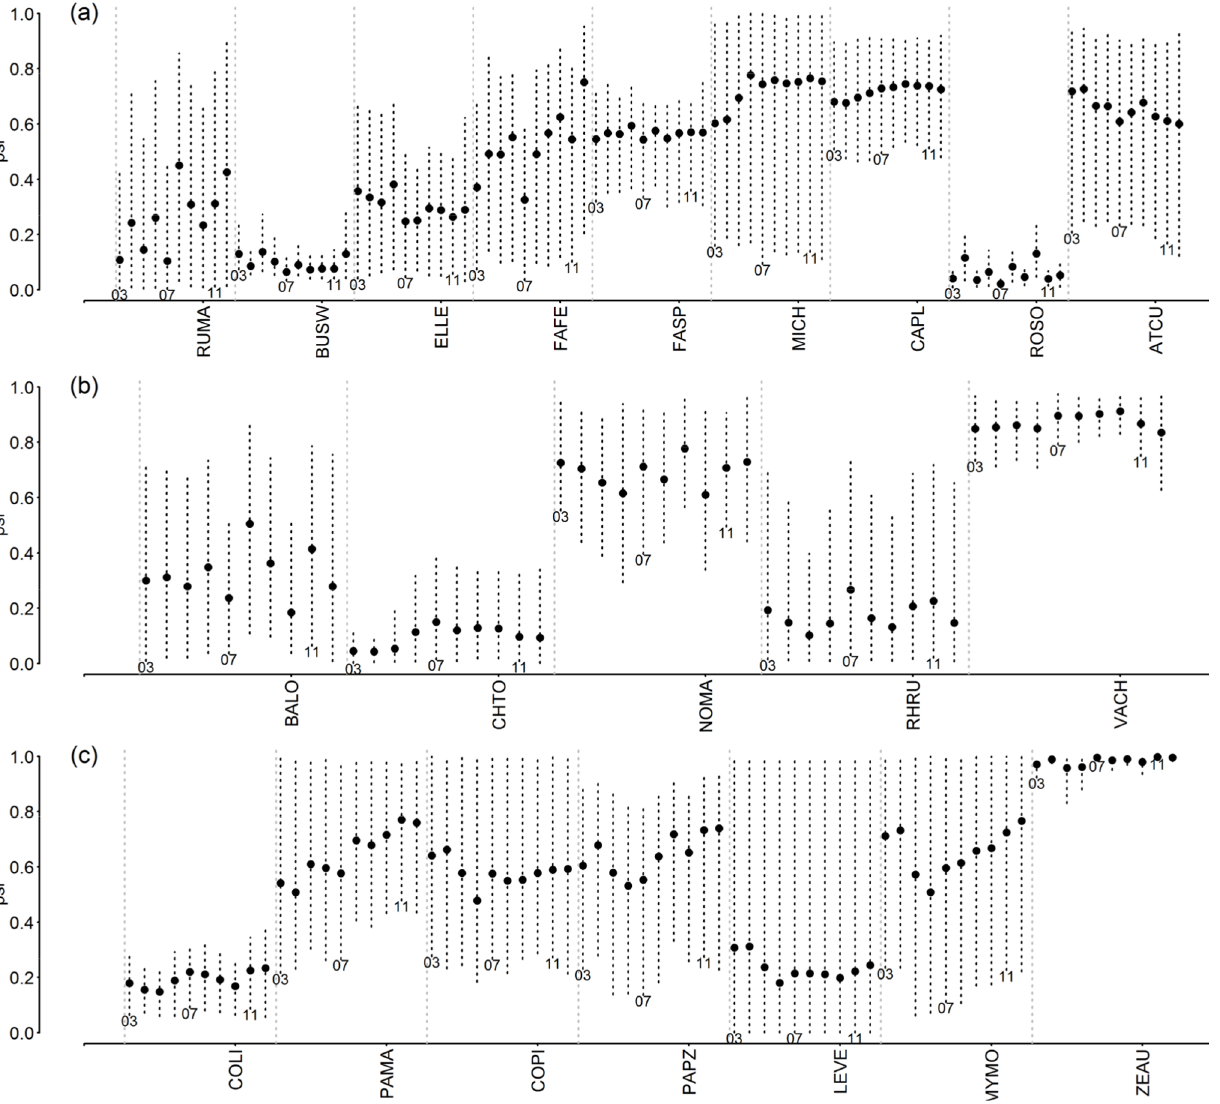
Fig 3. Mean occupancy ( ^ ψ ± SD, 95% BCI) for the complete study area during 2003 – 2012, in the regional bird monitoring program in Argentina for Non Passeriformes species. (a) Raptors; (b) ground omnivores and herbivores; (c) ground granivores. For details of species names and guilds, see